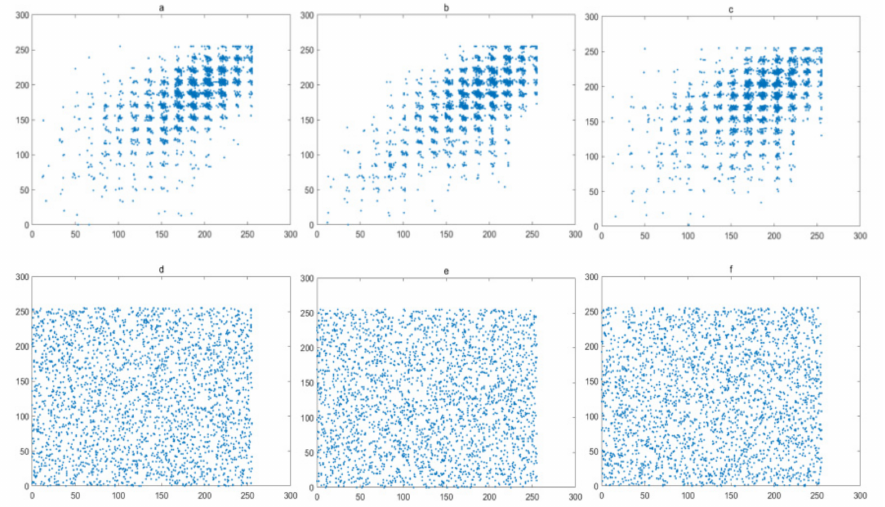
Figure 18. Correlation analysis of Horse image: ( a – c ) horizontal, vertical and diagonal direction of plain-text image; ( d – f ) horizontal, vertical and diagonal direction of cipher.